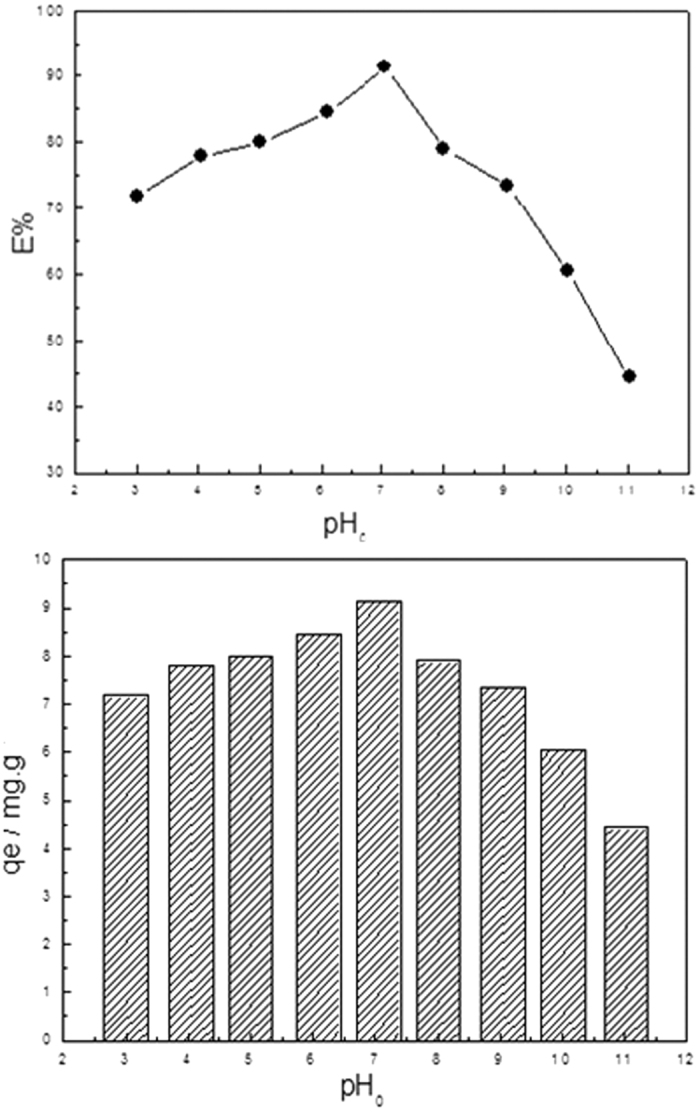
(a) Effects of the pH on the phosphate removal efficiency E%. (b) adsorption capacity qe to Fe3O4@NH2-MIL-101(Fe). (Fe3O4@NH2-MIL-101(Fe), 12 mg; NaH2PO4 c0 = 0.6 mgL−1; V = 0.2 L; T = 293 K).